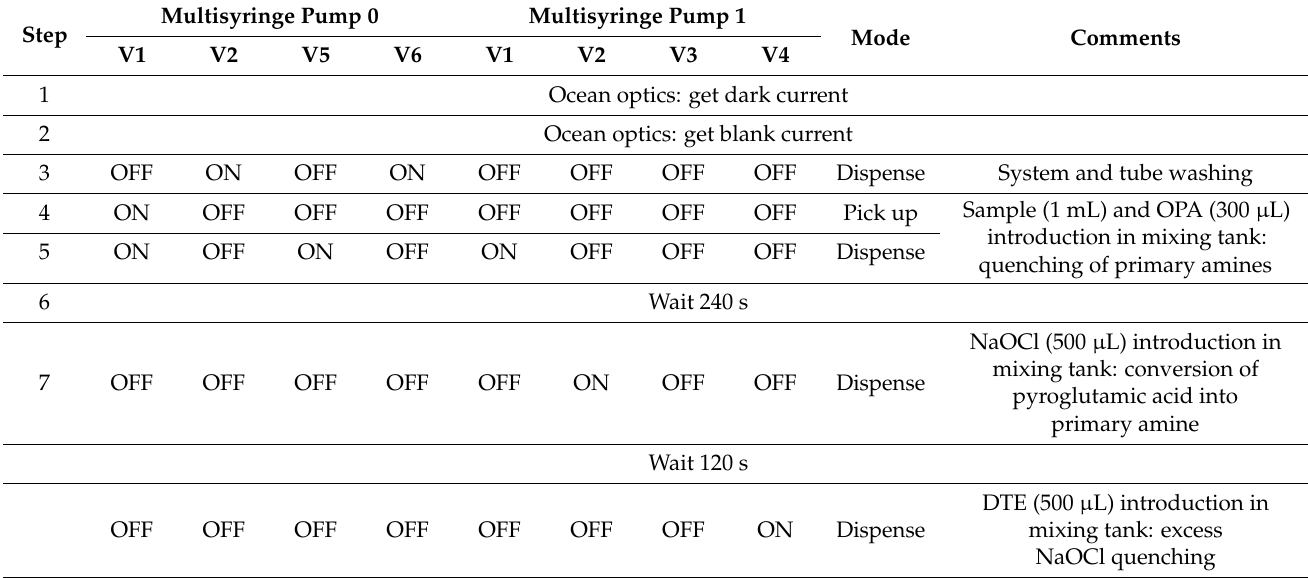
Table 1. Detailed multisyringe flow injection analysis procedure for the determination of tropomyosin in shrimp samples. Multisyringe Pump Step